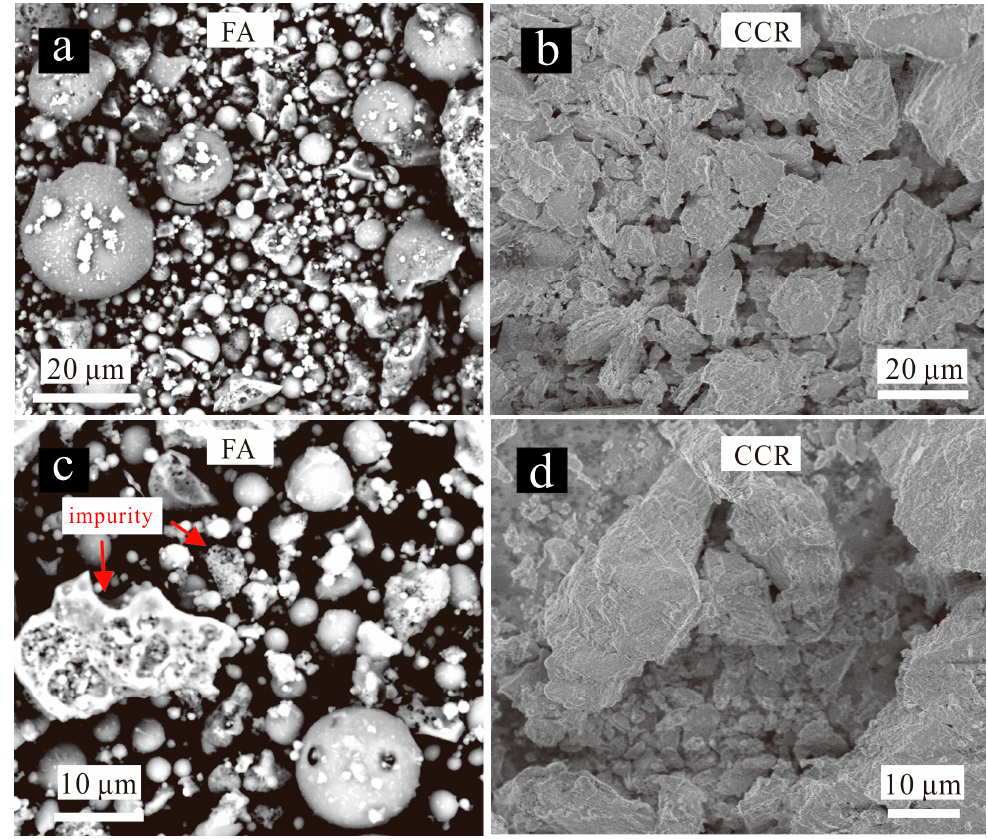
Figure 7. SEM images of FA and CCR. ( a , c ) CCR; ( b , d ) FA. In Figure 8, the panel pairs 8a-b, 8c-d, 8e-f, and 8g-h show the microscopic mor- phology of FA/CCR-based geopolymers of FA2CCR1-0.4-50 ◦ C, FA1CCR1-0.4-50 ◦ C, FA1CCR2-0.4-50 ◦ C, and FA1CCR2-0.4-80 ◦ C respectively at low and high